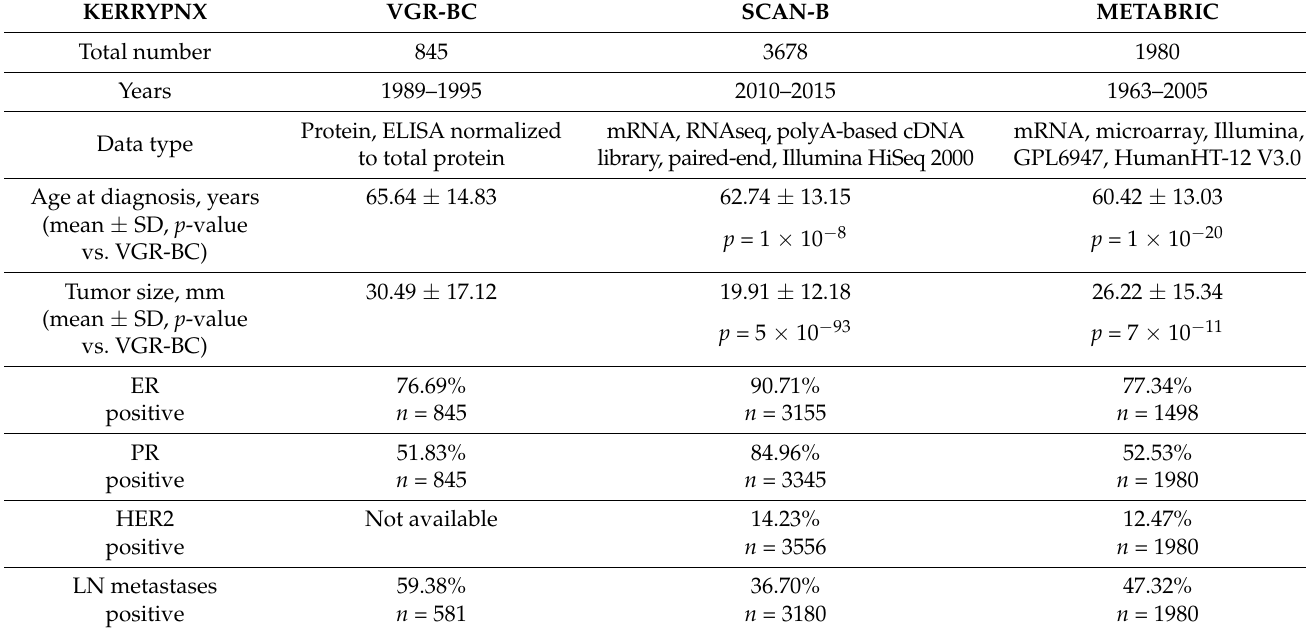
Table 1. Clinical characteristics of the breast cancer